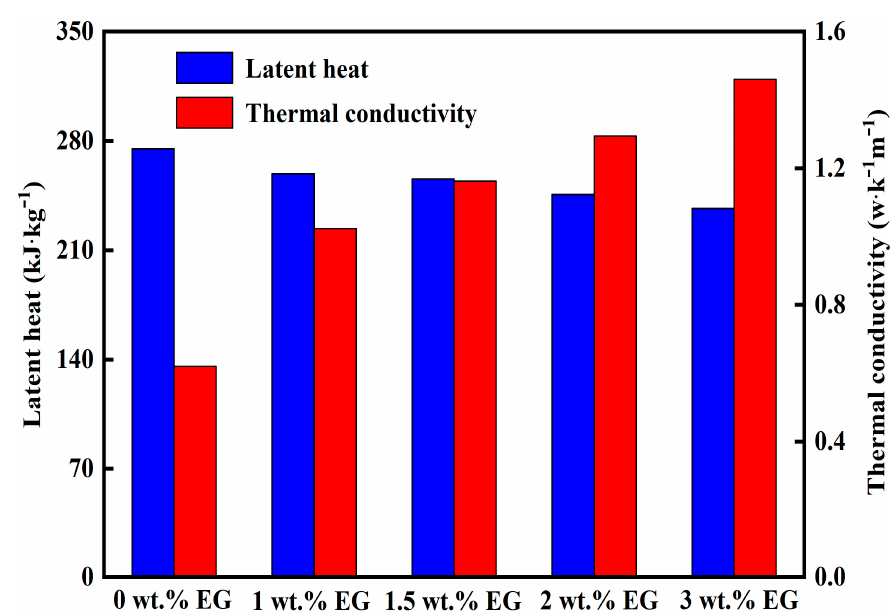
Figure 10. The relationship between EG and latent heat and thermal conductivity.